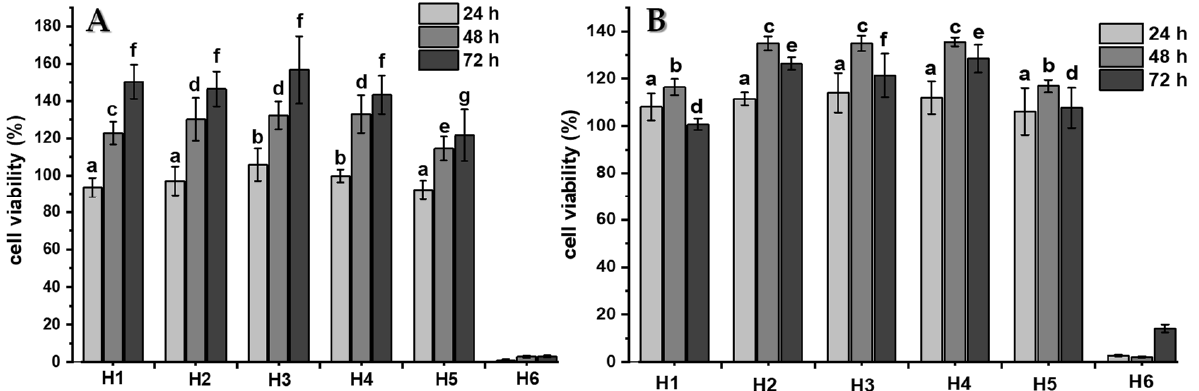
Figure 8. Cytotoxicity evaluation of the hydrogel’s extracts exposed to C28 ( A ) and 3T3 ( B ) cells using the MTS assay method. There are no significant differences among several compared samples at the same time interval, for any letters, in each graph ( p ≥ 0.05).